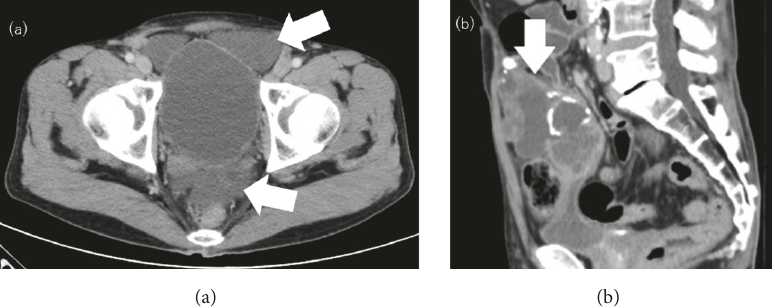
Figure 2: (a) Abdominal computed tomographic image taken after five cycles of gemcitabine and cisplatin (GC). Abdominal fluid was detected (white arrows). (b) Abdominal computed tomographic image taken after FOLFIRI ( ℓ -leucovorin + 5-fluorouracil + irinotecan). The tumor size had decreased to 7 cm (white